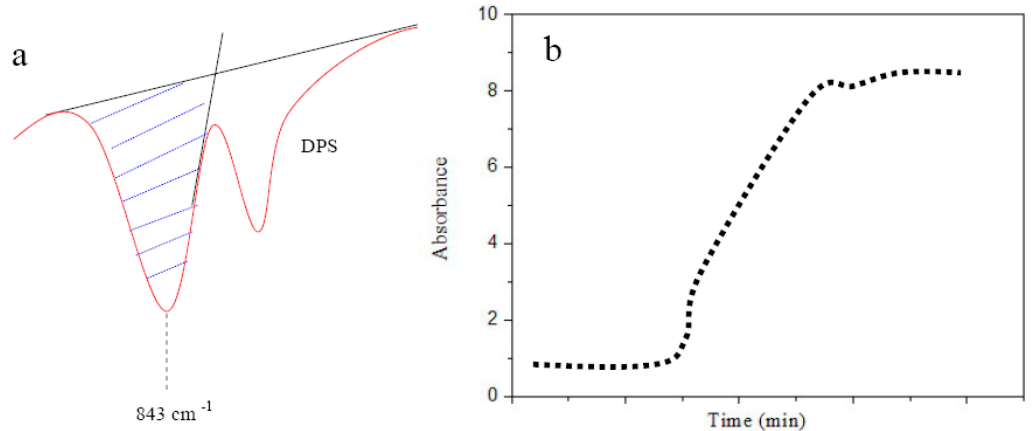
Figure 3. Calculating method of diffusion coefficient, ( a ) the fairly specific absorption band for DPS at 843 com − 1 selected as a marker band to calculate the diffusion coefficient, the integrated peak area determined as absorbance; ( b ) a logarithmic scale curve of time-absorbance, the sloping line in the horizontal direction determined by the diffusion coefficient.